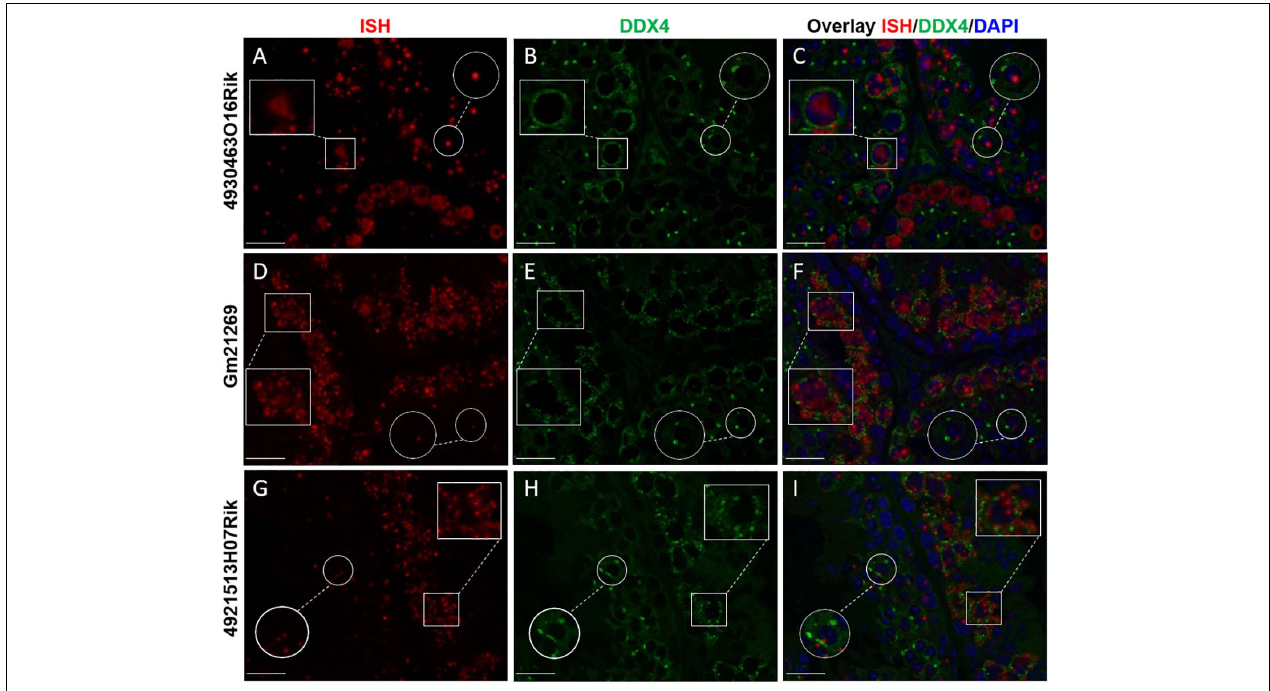
FIGURE 3 | lncRNA cellular localizations on WT 2-month-old mouse testes. In situ hybridization using (A) 4930463O16Rik , (D) Gm21269, and (G) 4921513H07Rik probes (red). (B,E,H) Immunofluorescence staining with DDX4 antibody was achieved at the same stage of seminiferous epithelium to identify male germ cells (green). (C,F,I) DAPI (blue), visualizing nuclear chromosomes, was merged with IS H (green) and IF (red) signals. Zooms in white squares show spermatocytes during the first meiotic division (zygotene to diplotene stages). Zooms in circles show spermatid cells with one spot of DDX4 staining per cell. Scale bar = 20 µ